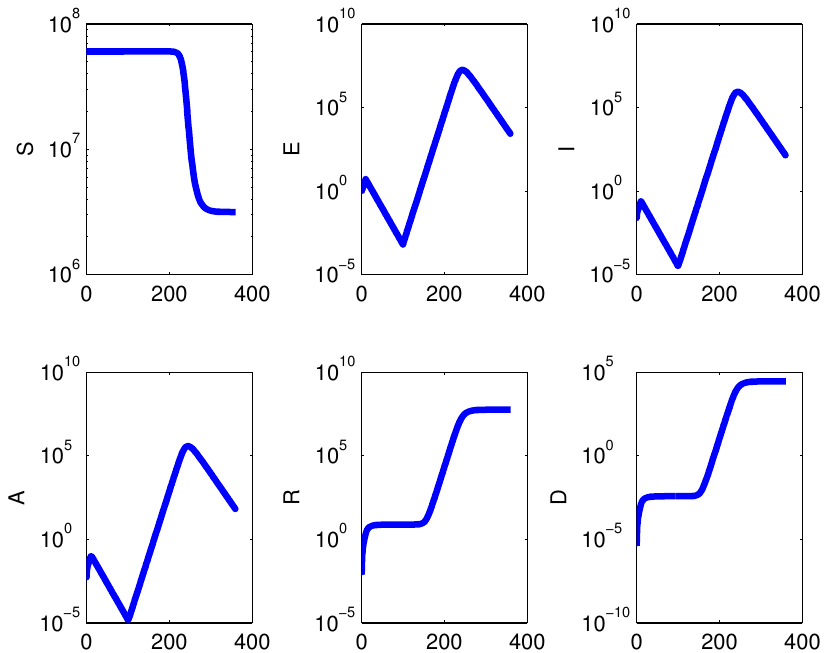
Figure 10. Using a semilogarithmic scale for the vertical axis, we show the results of absolute isolation, β I = 0 starting at time t 1 = 10, setting β I = 0 and lifting it at time t 2 = 90, returning to β I = 10 − 7 three months later, over a one year timespan for the model with no demographics (1) where Λ = d p = 0. Left to right and top to bottom, the subpopulations are: S , E , I , A , R and D , the disease-related deceased